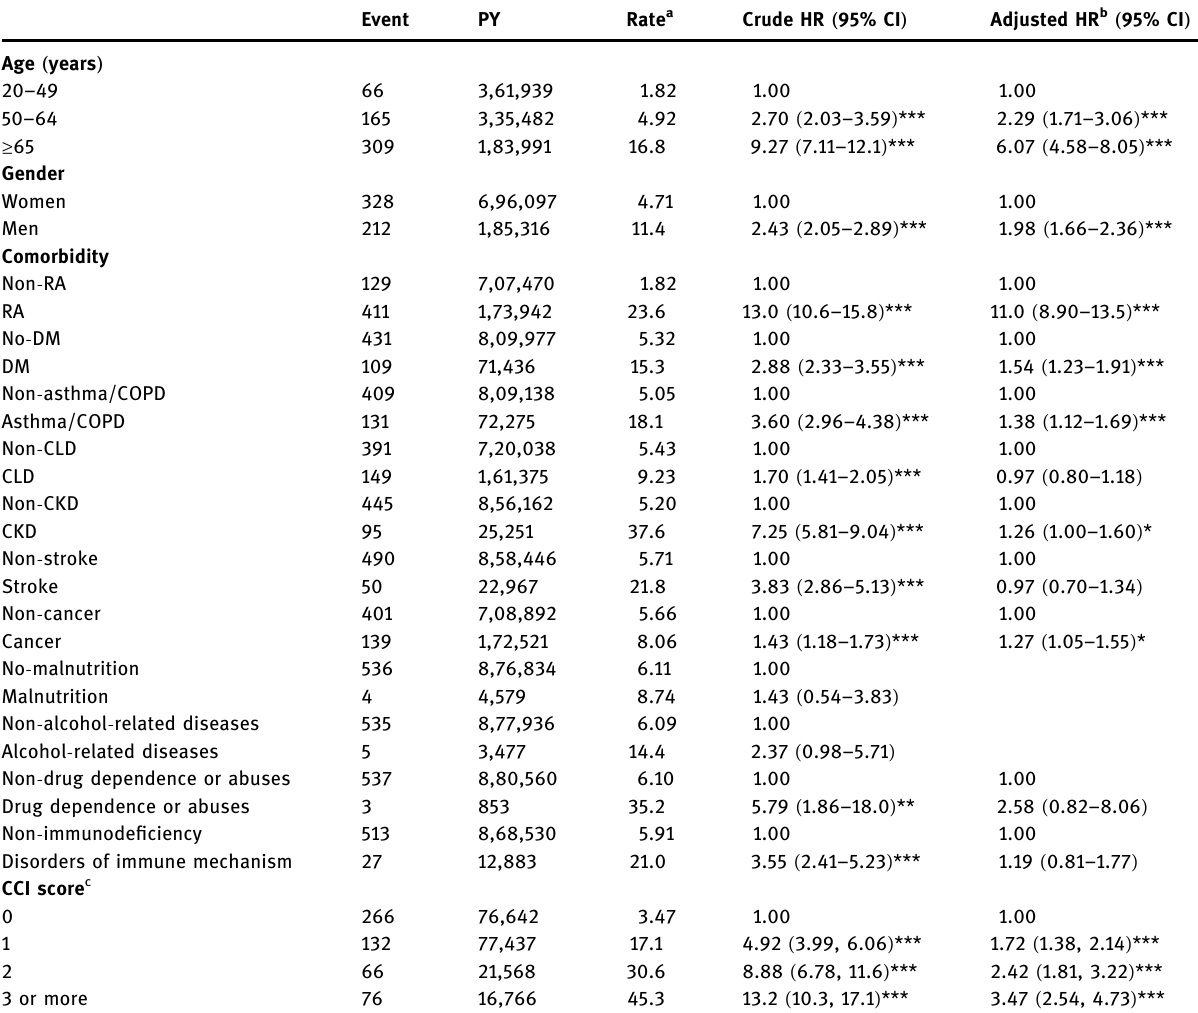
Table 2: Potential risk factors for pleural